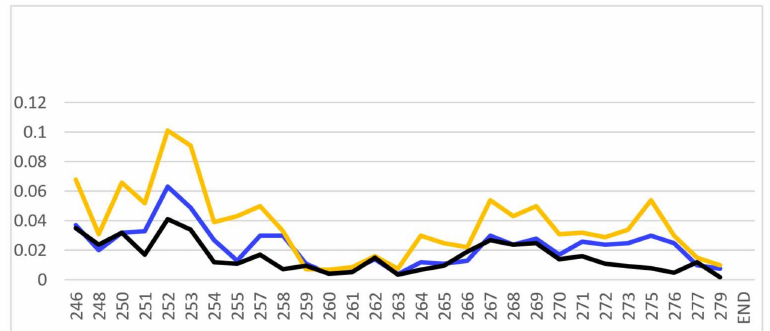
Figure A2. Comparison of the CSPs for binding of PSTD-CMP-Sia (blue), PSTD-Sia (yellow), and PSTD-DP 3 (black) based on the overlaid 1 H- 15 N HSQC spectra of their